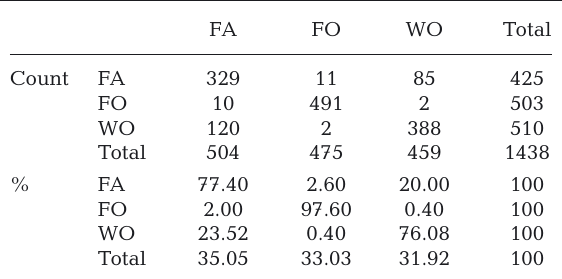
Table 2. Jack-knife classification score results (in counts and %) for the canonical variate analysis of the 3 origins of gilt- head seabream from the eastern Adriatic Sea (FA: farm-as- sociated, FO: farm origin, WO: wild origin). Overall,